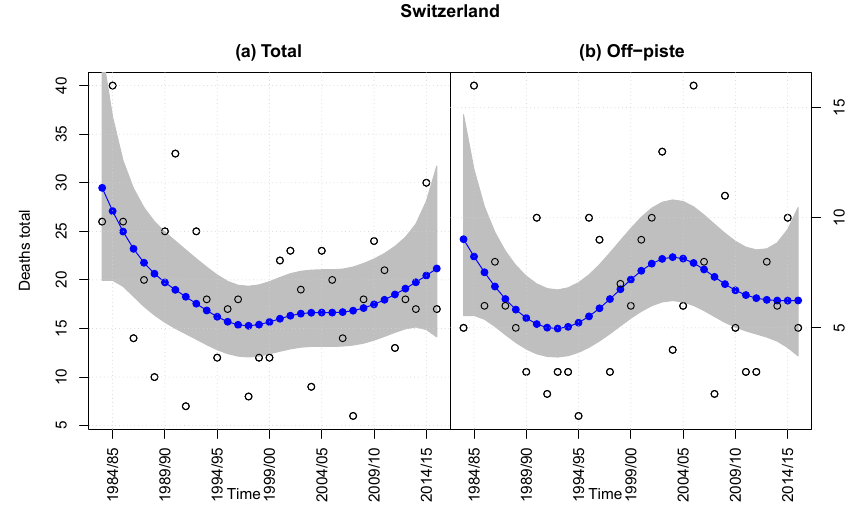
) annual avalanche fatalities – off-piste and backcountry, i.e., total, in (a) and off-piste in (b) – with Figure 3. Observed ( ◦ ) and estimated ( • 90% confidence bands (grey) in Switzerland within 1983/1984–2015/2016.